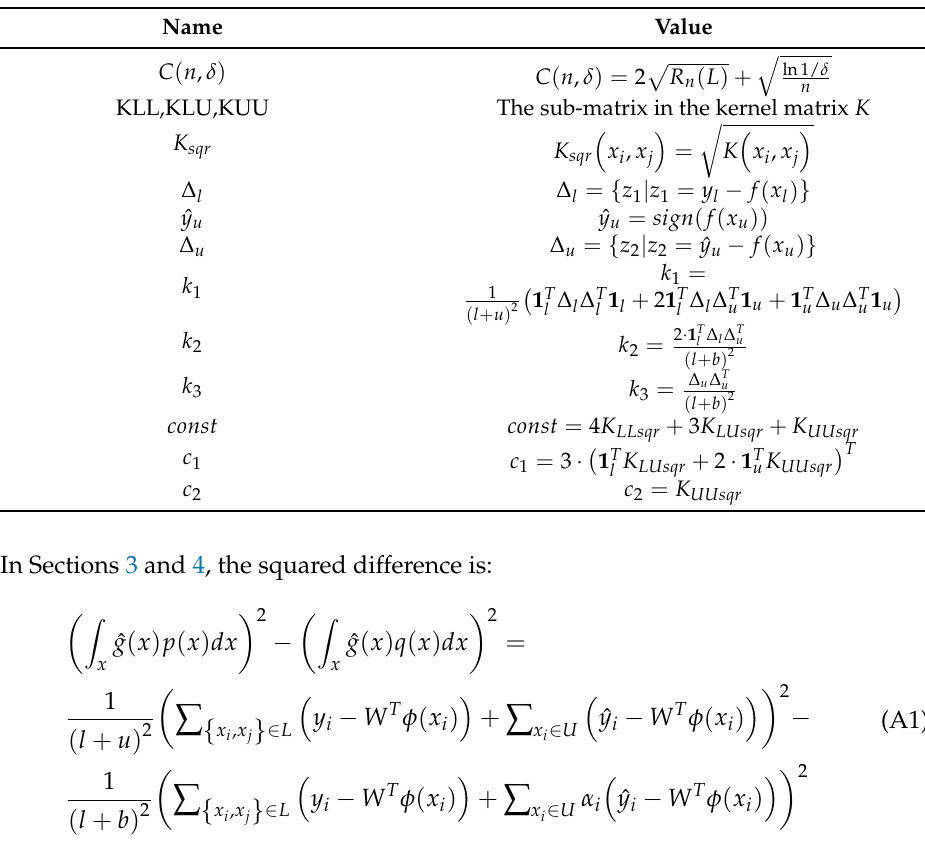
Table A1. Related